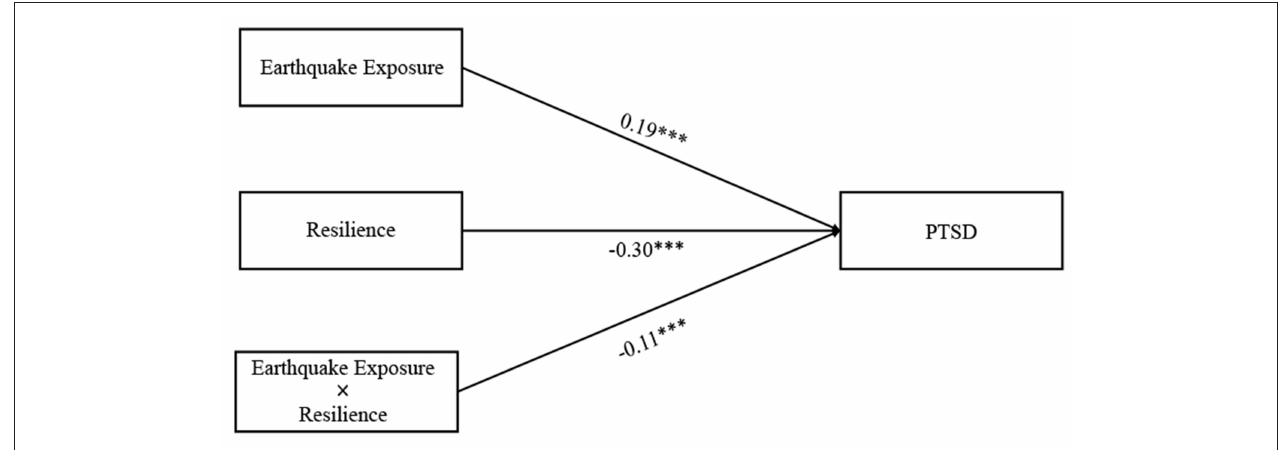
FIGURE 2 | The moderating effect of resilience on the direct relationship between earthquake exposure and PTSD symptoms.